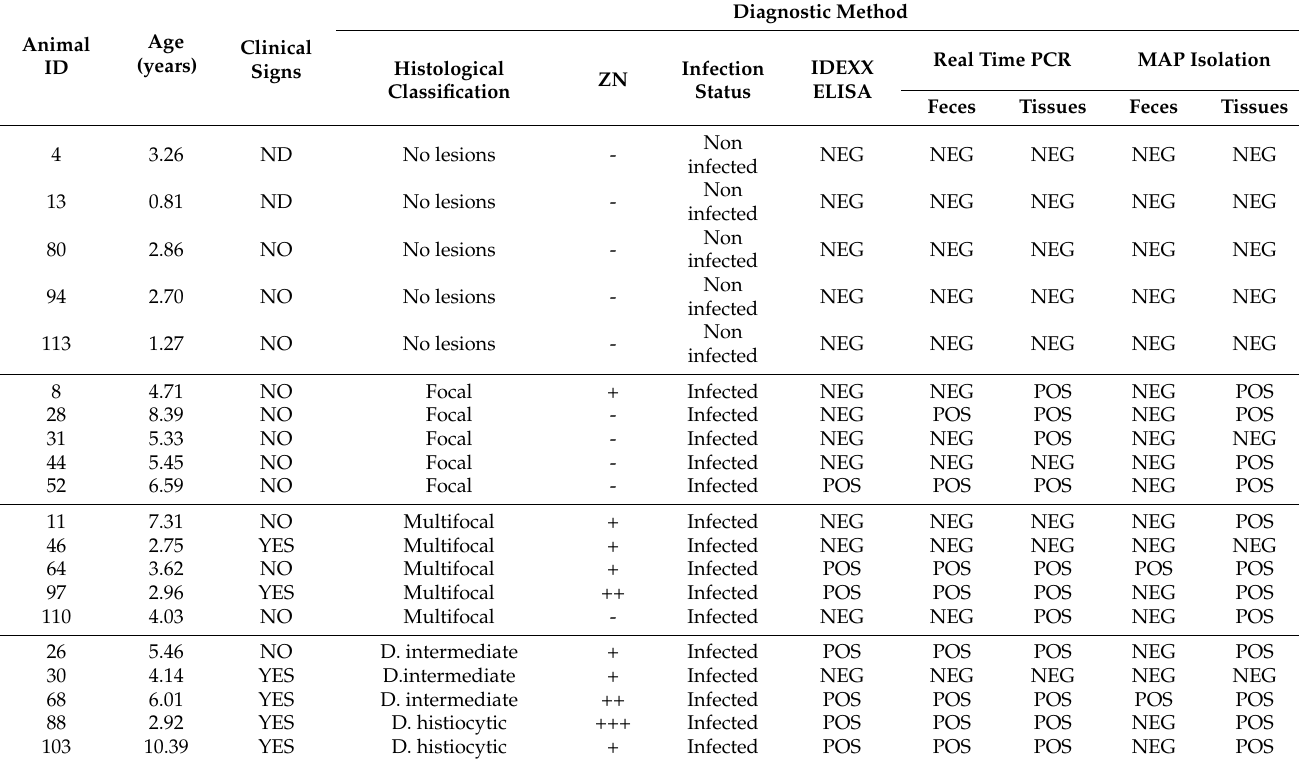
Table 1. MAP infection status of the 20 Holstein Frisian cows used in this